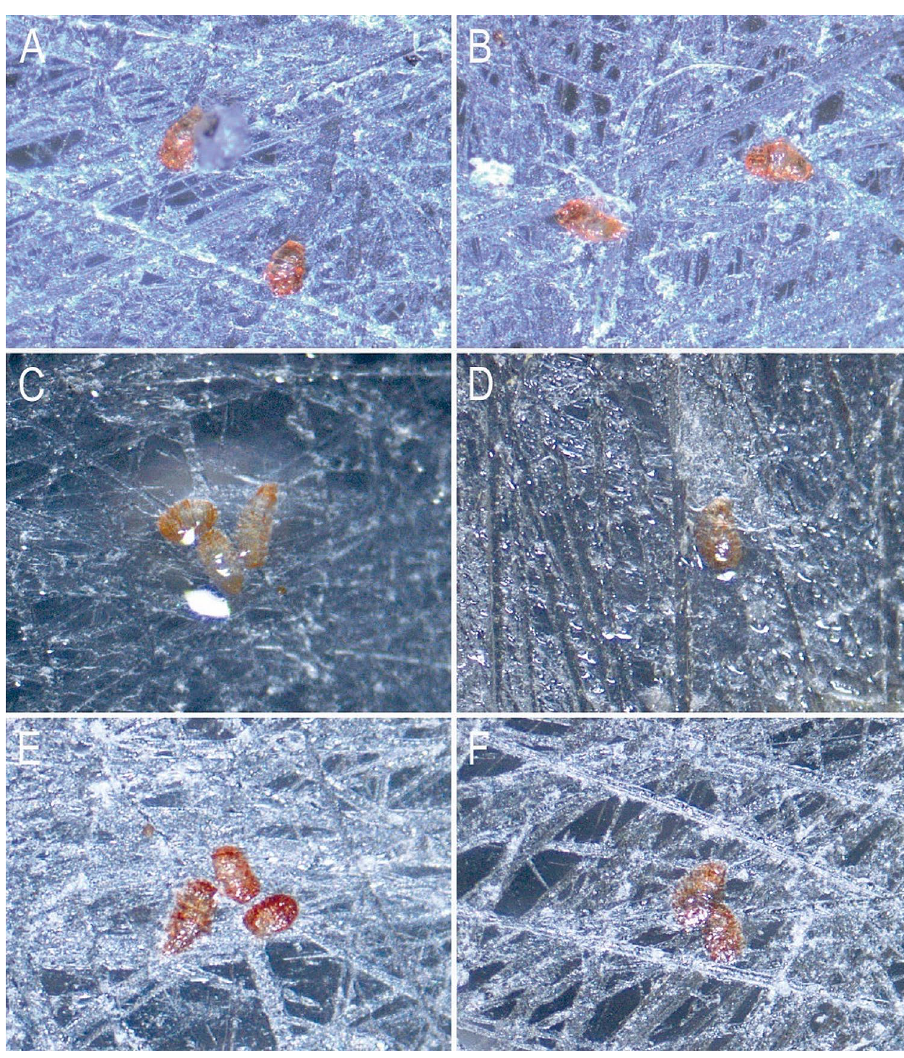
Figure 3. Milnesium inceptum tuns: ( A , B ) before contact with snail mucus; ( C , D ) coated with wet snail mucus; ( E , F ) coated with dry snail mucus. Figures were assembled in Corel Photo-Paint 2017 (http:// www. corel.